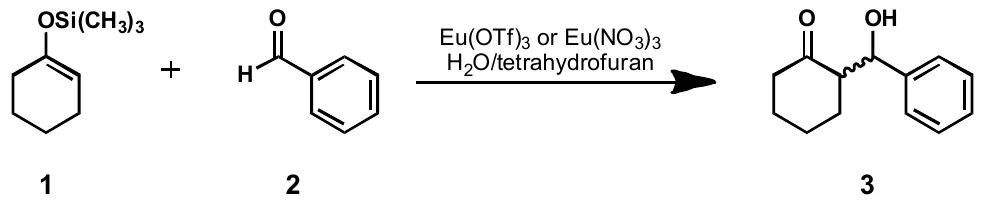
Figure 1. The water-tolerant Mukaiyama aldol reaction between silyl enol ether 1 , and benzaldehyde ( 2 ), studied in this